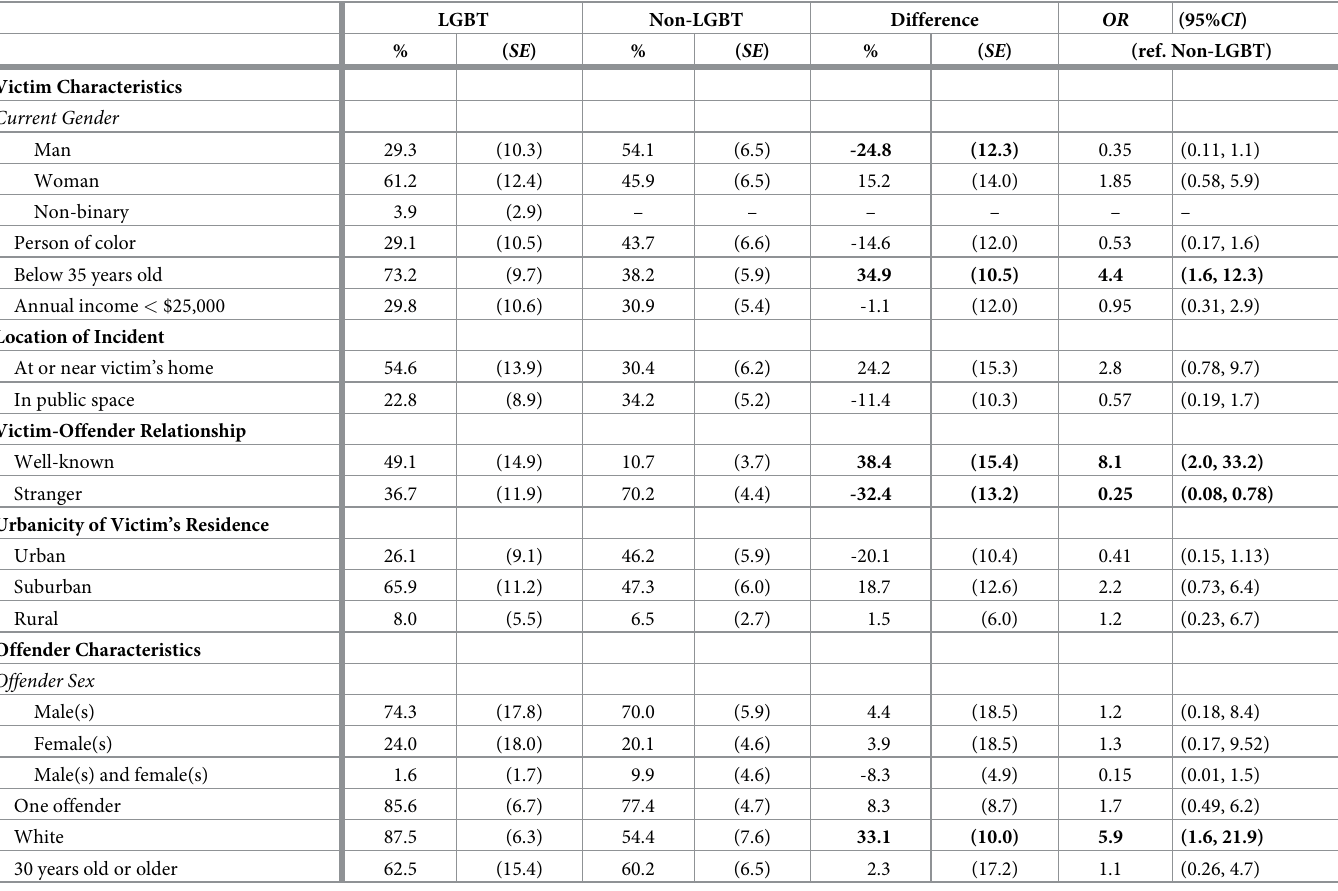
Table 2. Victimization characteristics of violent hate crime, LGBT versus non-LGBT, United States, National Crime Victimization Survey